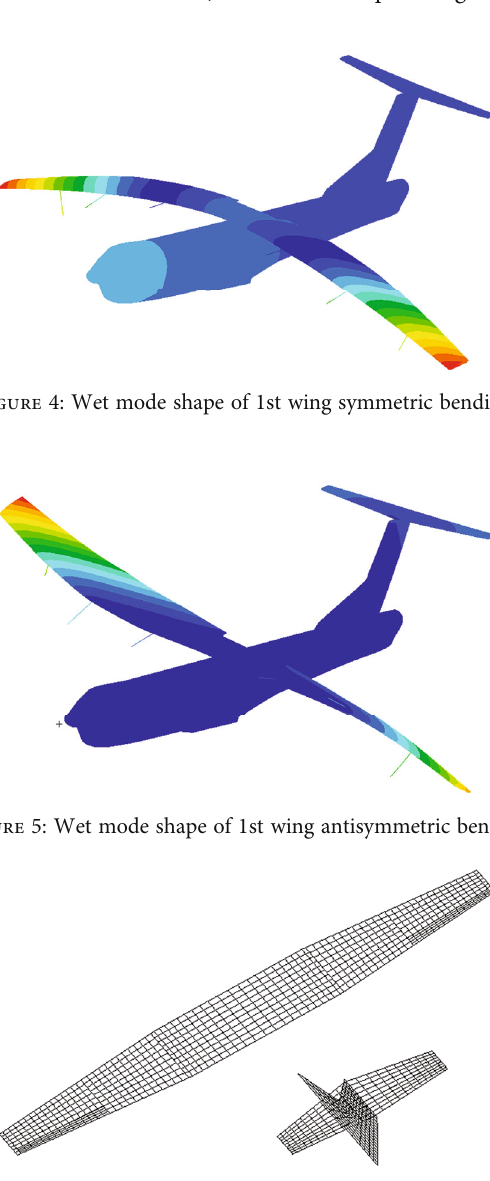
Figure 6: The con fi guration of lifting